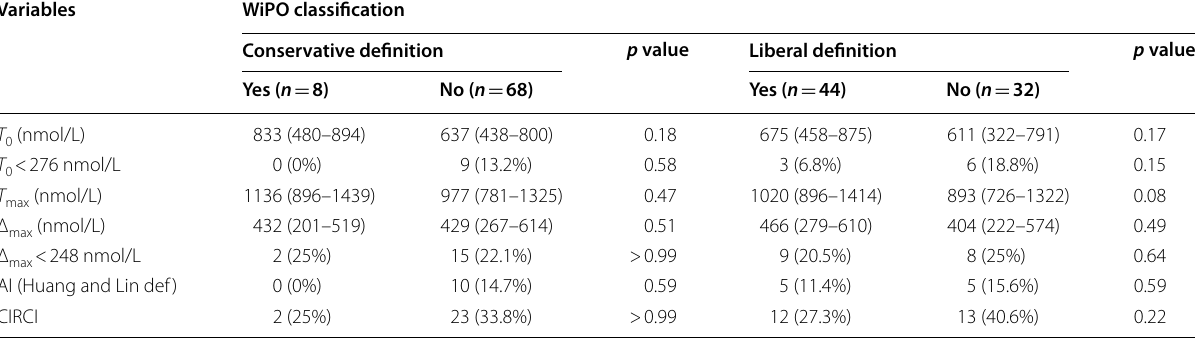
Values are expressed as mean ( SD) or median (IQR) as appropriate ± WiPO: weaning-induced pulmonary oedema, T 0 : baseline plasma cortisol (before short corticotropin test), T max : maximal cortisol post-stimulation, Δ max : maximal cortisol response, AI: adrenal insufficiency (Huang and Lin